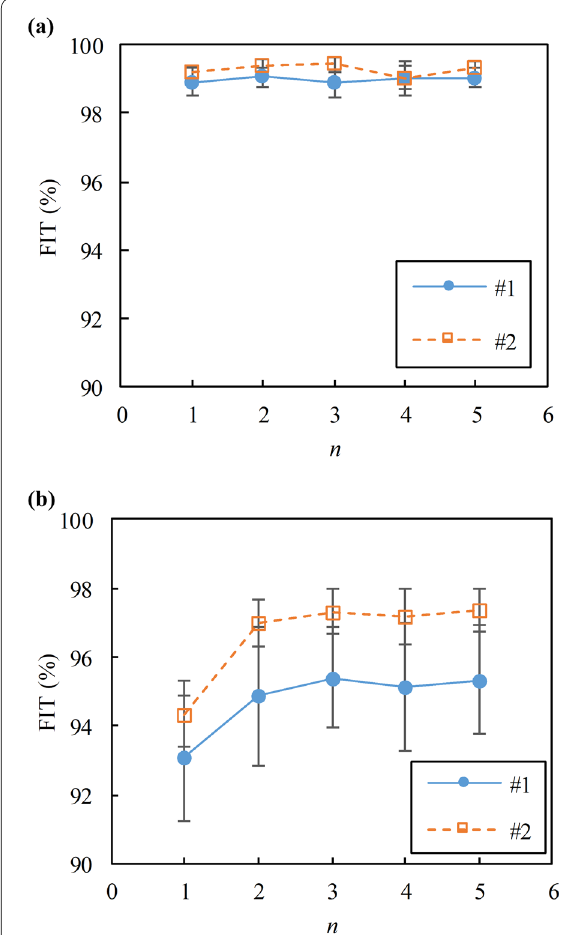
Fig. 13 Average FIT values for different conditions. a T < T g . b T > T g